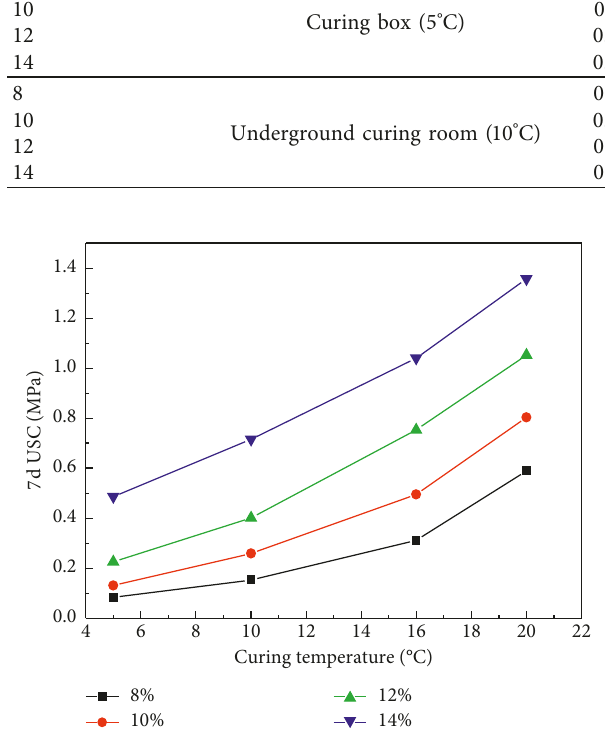
Figure 5: UCS at the curing temperature of 7days.